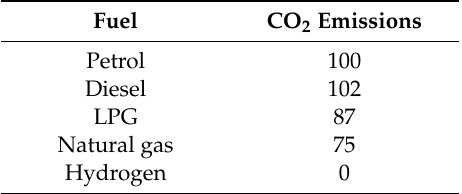
Table 2. Potential for CO 2 production of various fuels (adapted from